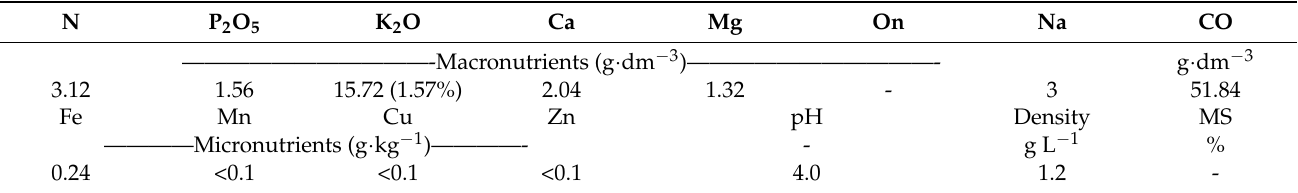
Table 2. Physicochemical characteristic of vinasse residue used in the